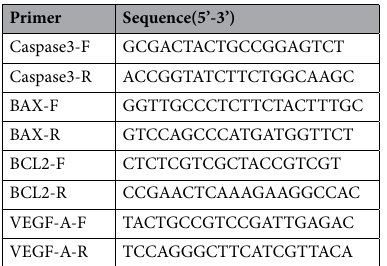
Table 6. Primers used in the present